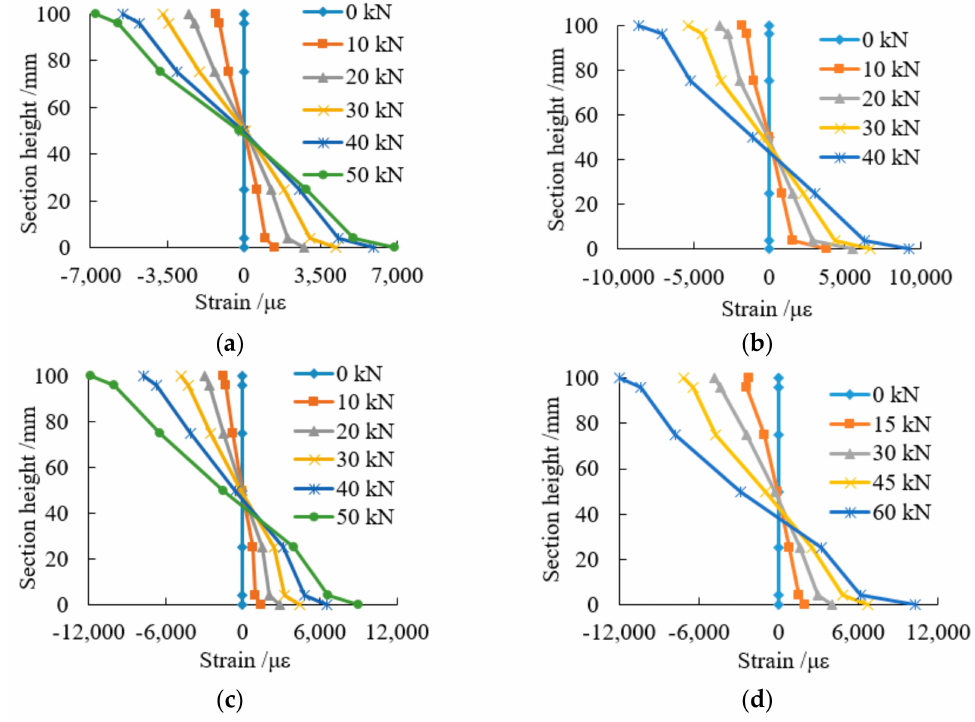
Figure 14. Strain of cross section of typical specimens: ( a ) strain of cross section of NAP-3; ( b ) strain of cross section of LAP1-2; ( c ) strain of cross section of LAP2-2; ( d ) strain of cross section of